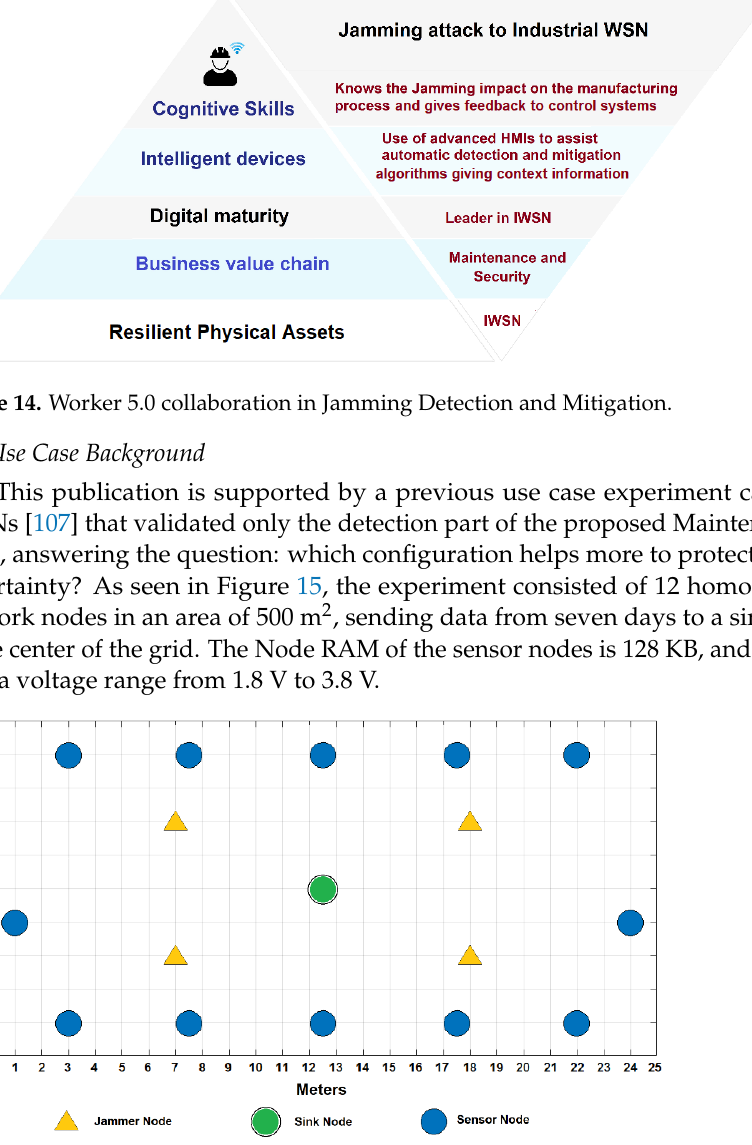
Figure 15. Distribution of the IWSN nodes of the experiment. Image obtained from [107].